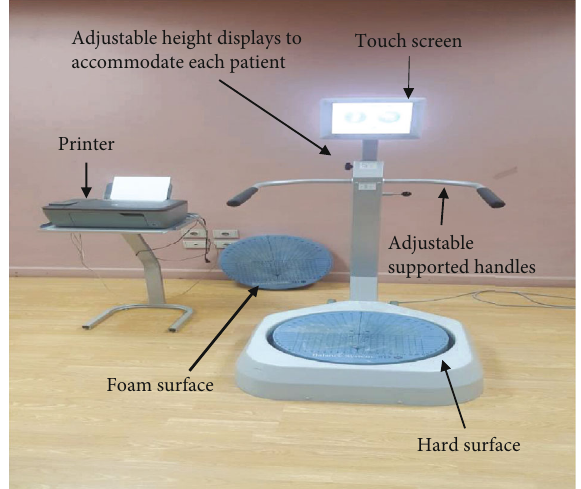
Figure 2: Biodex balance